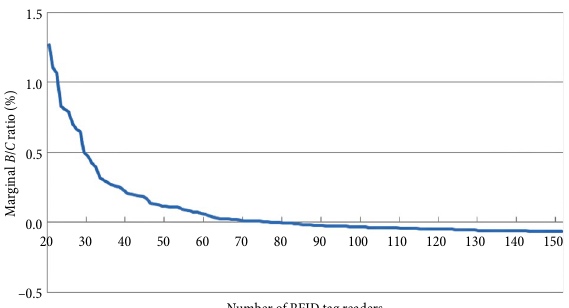
Fig. 7. Number of RFID reader locations and